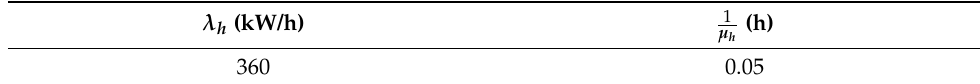
Table 2. Arrival rate and service rate of M/M/ ∞ model.